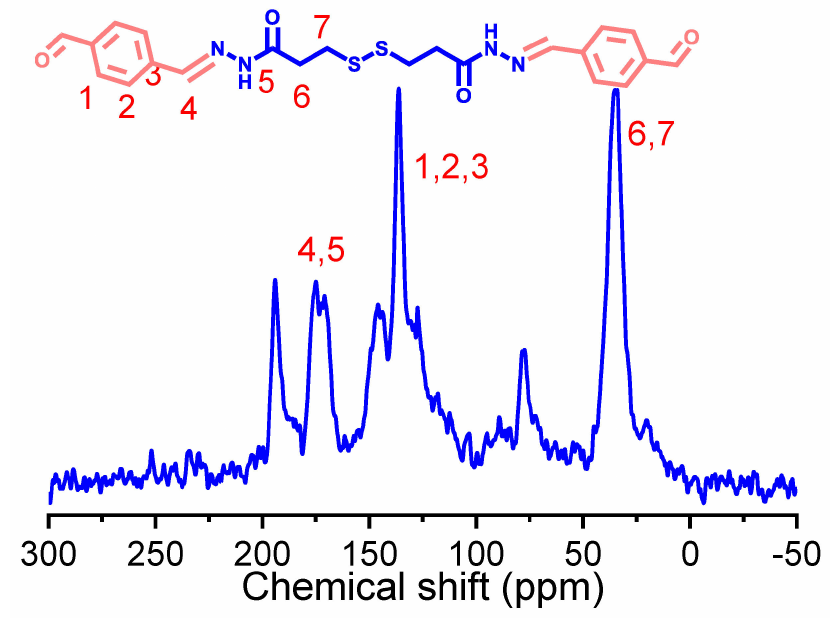
Figure 2. Solid-state 13 C-NMR spectrum of